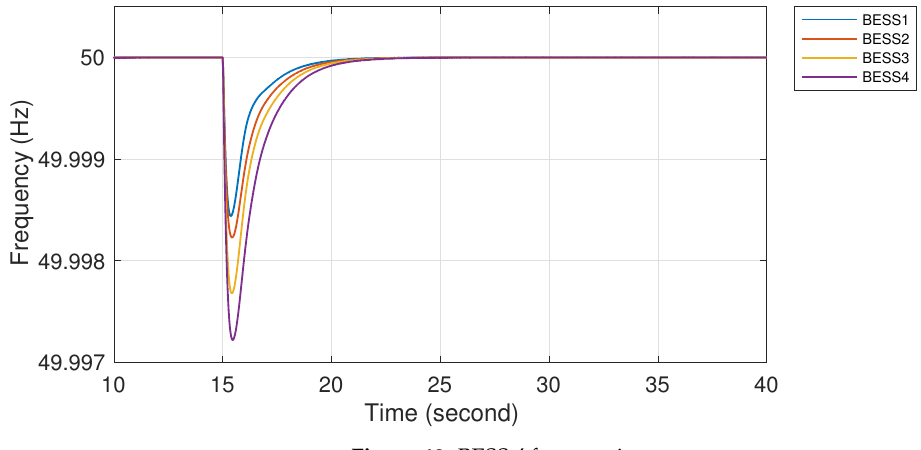
Figure 12. BESSs’ frequencies.